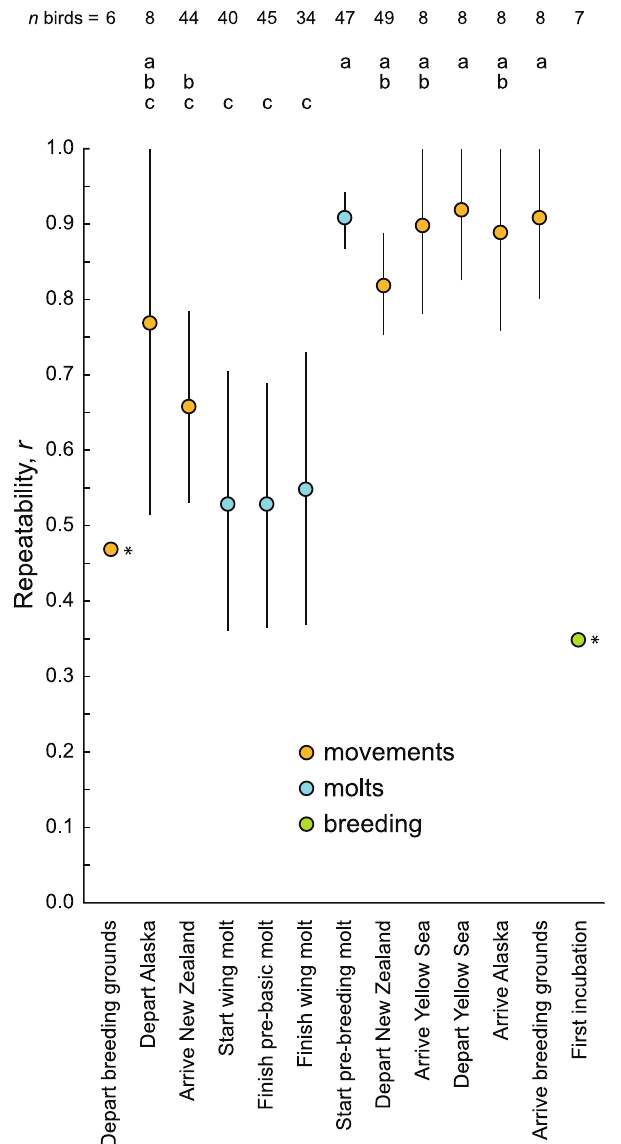
Figure 3. Individual repeatability in timing throughout the annual cycle of bar-tailed godwits. Individual repeatability ( r ) among color-banded (New Zealand only) or geolocator-tracked (outside New Zealand) godwits (see Table 1). Whiskers indicate 95% confidence intervals. Asterisks indicate non-significant r values. Letters indicate significant differences based on non-overlapping confidence intervals. not decrease chronologically from New Zealand departure to arrival on breeding grounds at the population level (SD: r s = 0.20, n = 5, P = 0.66) or individual level (mean: r s =0.36, n = 5, P = 0.28; SD: r s = 0.30, n =5, P = 0.34). Repeatability did not increase across spring migration ( r s =0.50, n = 5, P = 0.23).